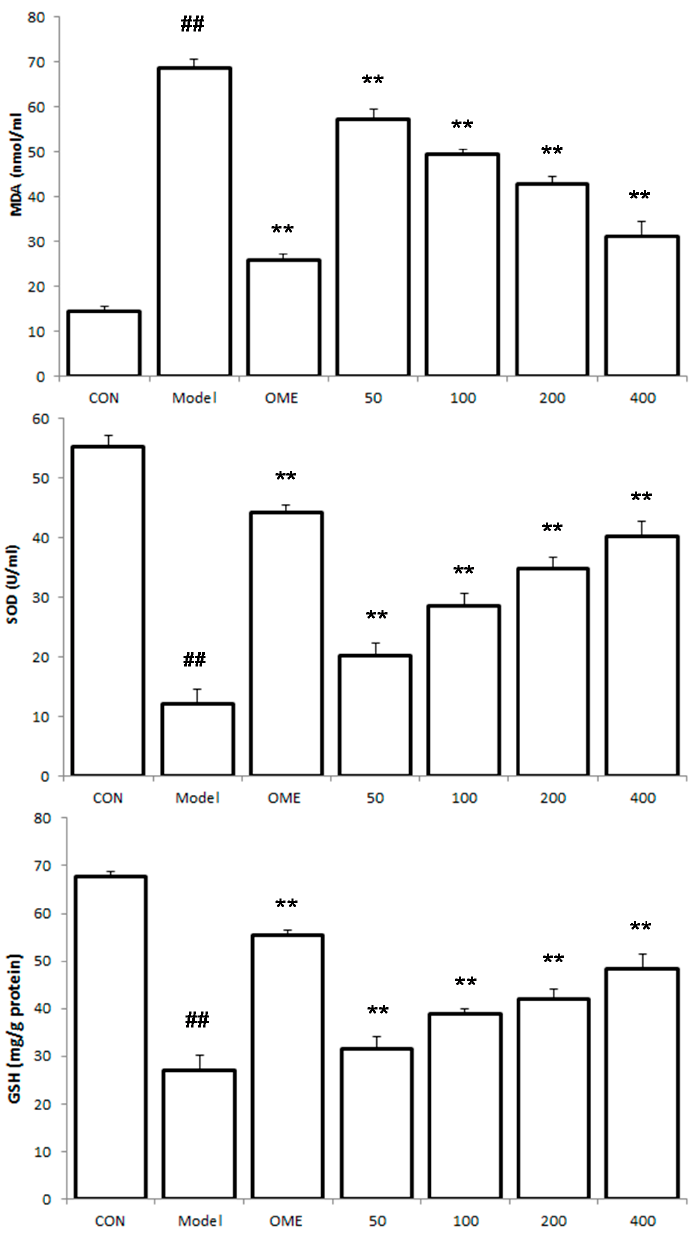
Figure 4. Effect of LCA on MDA, SOD and GSH levels. Data are expressed as the mean ± SD ( n = 8). ##: p < 0.01 vs. control group. **: p < 0.01 vs. model group. (CON = control; OME = omeprazole).